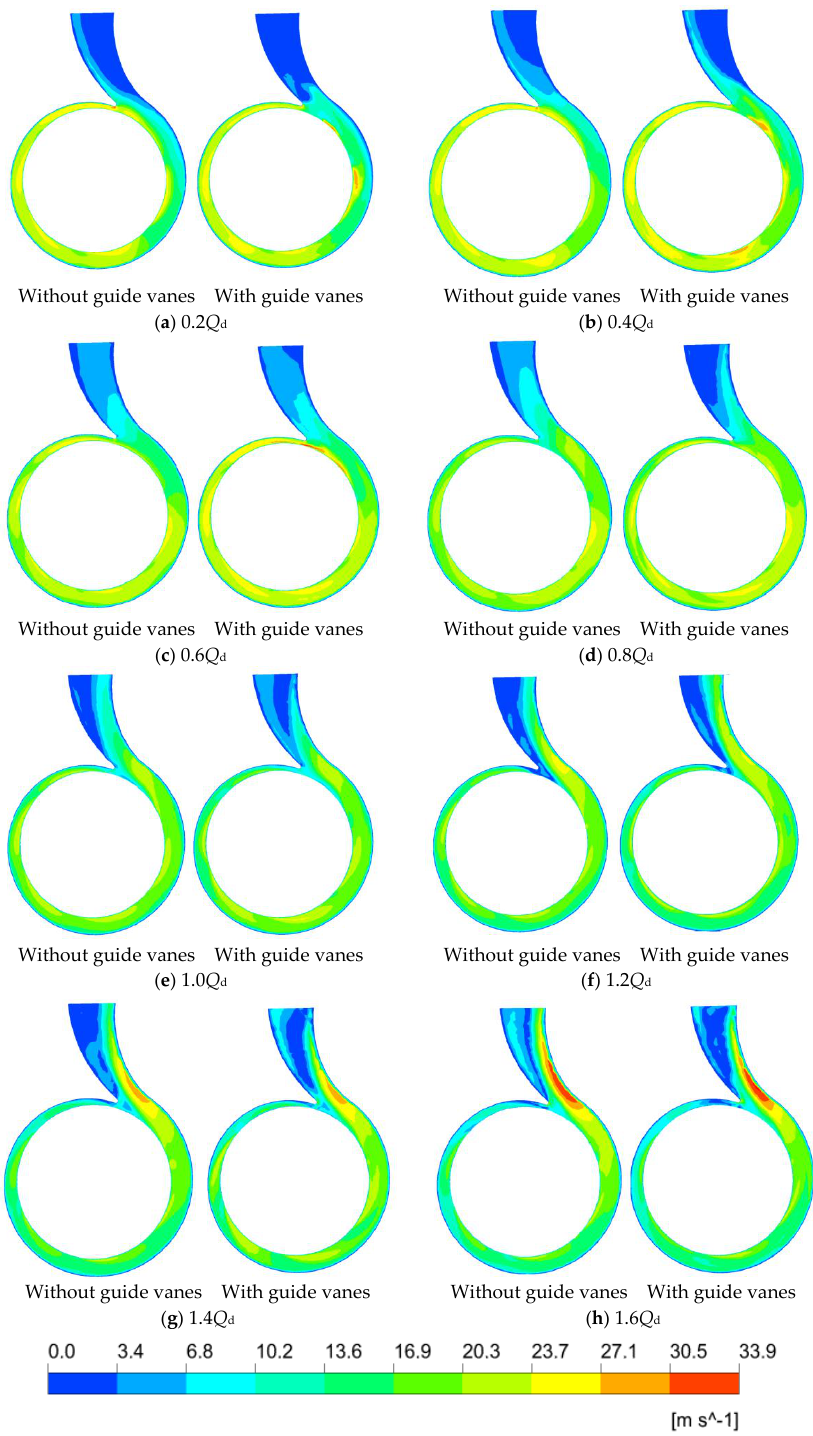
Figure 10. Velocity distribution in the volute cross-section.